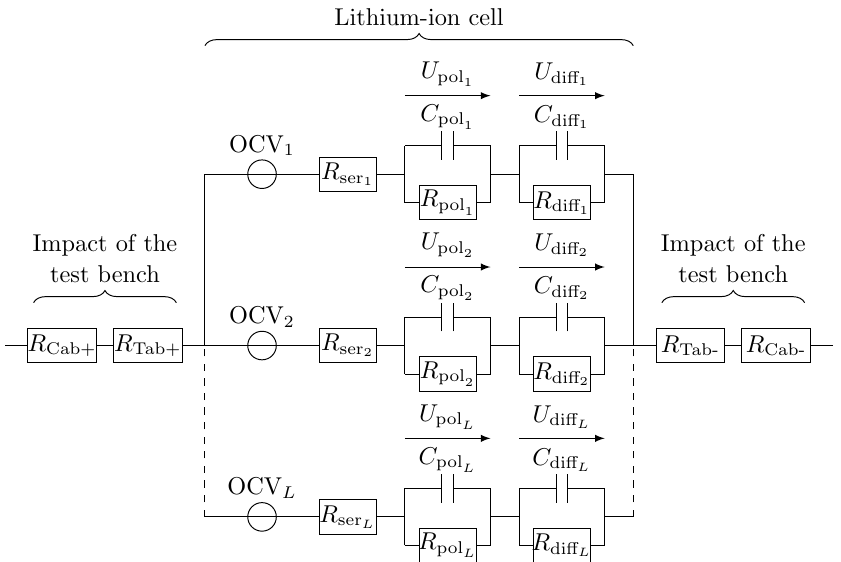
Figure 7. Extended dual polarization model—Resolution of the cell layers within the cell and consideration of the contact resistance of the tabs and cable resistances due to the connection of the cell to the cell